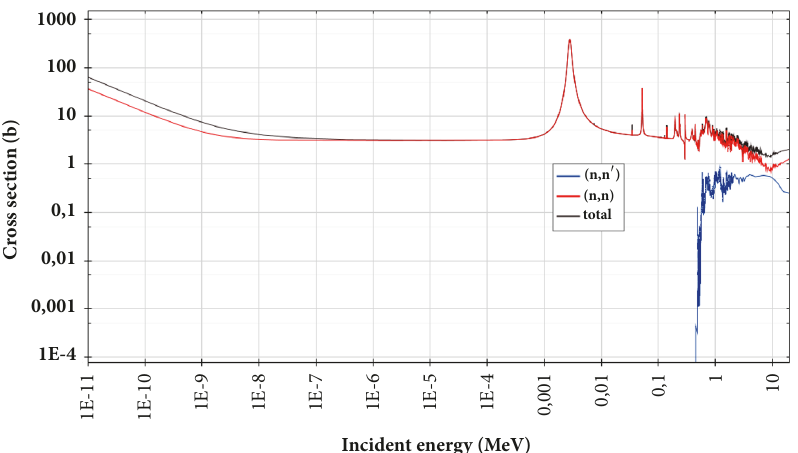
Figure 4: Total, elastic, and inelastic microscopic cross sections of 23 Na as produced by using the JEFF-3.1.1 Library [38] and the JANIS software [39].